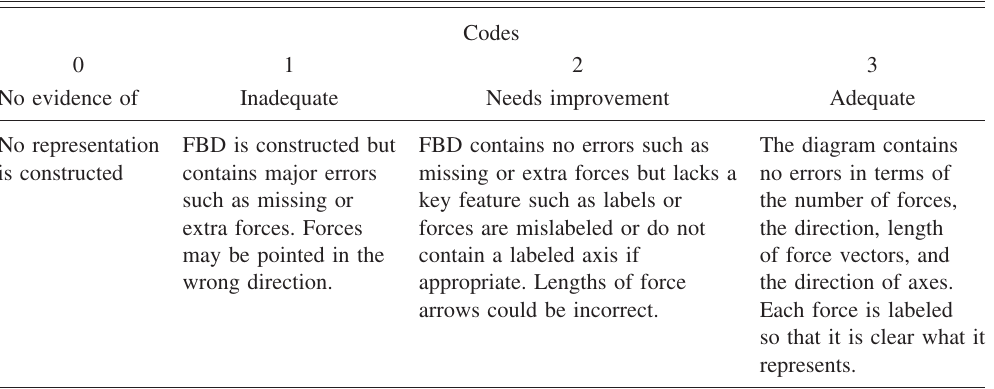
TABLE II. Rubric for coding free-body diagrams.